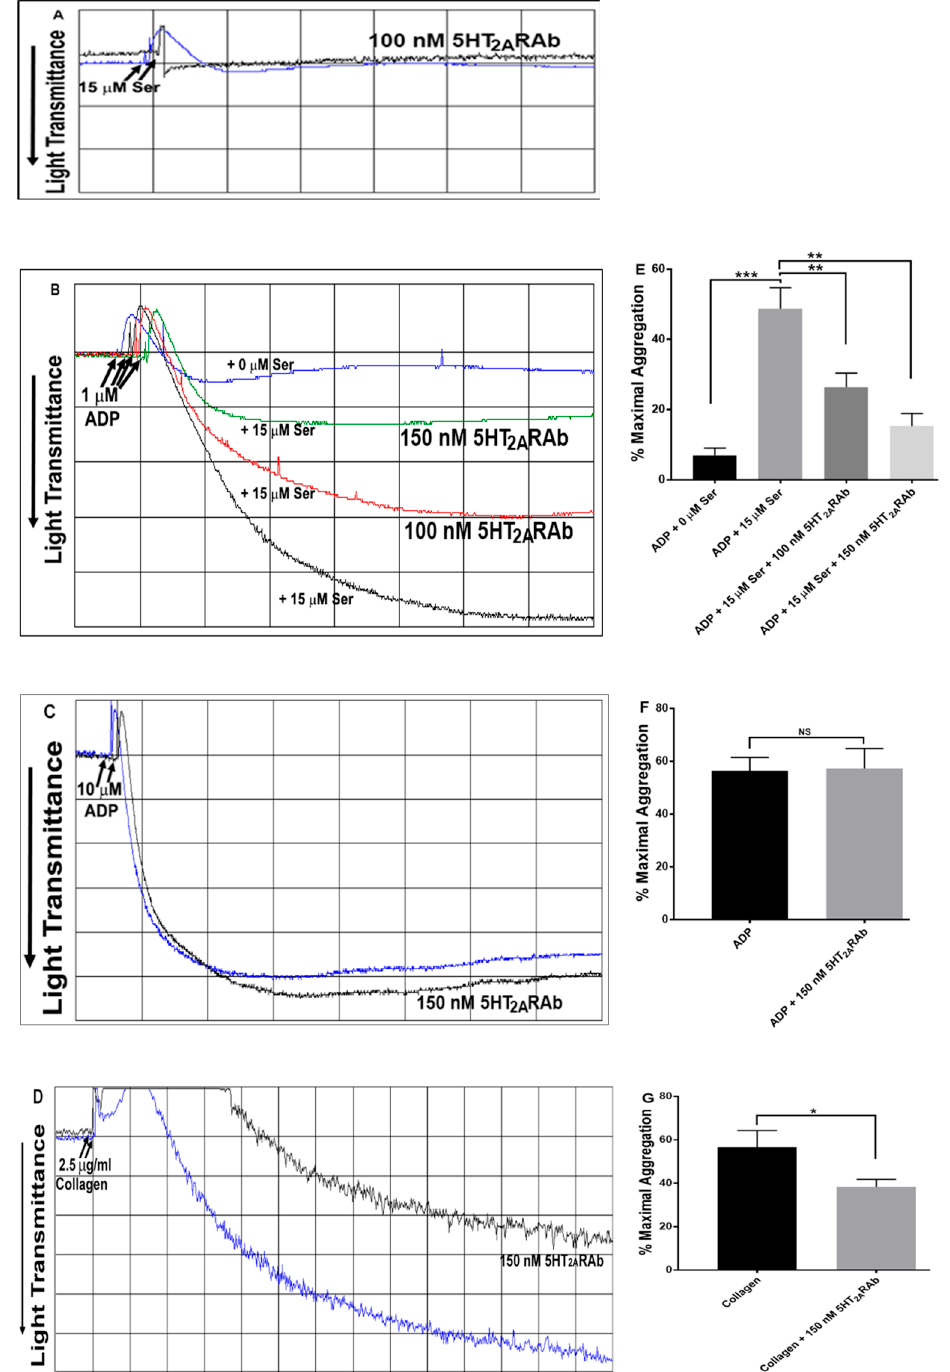
Figure 2. The 5HT 2A RAb inhibits serotonin-enhanced ADP-induced human platelet aggregation in vitro. ( A ) Human PRP was activated with serotonin (15 µ M), with or without pre-incubation for 5 min with the 5HT 2A RAb (100 nM). ( B ) Human PRP was incubated in the presence and absence of increasing doses of 5HT 2A RAb (100–150 nM) for 5 min before being activated with submaximal concentration of ADP (1 µ M) with or without serotonin (15 µ M); ( E ) shows quantification of the maximum aggregation data. ( C ) Human PRP was pre-incubated with 5HT 2A RAb (150 nM) for 5 min before activation with ADP (10 µ M); ( F ) shows quantification of the maximum aggregation data. ( D ) Human PRP was pre-incubated with 5HT 2A RAb (150 nM) for 5 min before activation with collagen (2.5 µ g/mL); ( G ) shows quantification of the maximum aggregation. (* p < 0.05; ** p < 0.01; *** p < 0.001; NS, nonsignificant). Each experiment was repeated three times, with blood obtained from three separate healthy human donors.